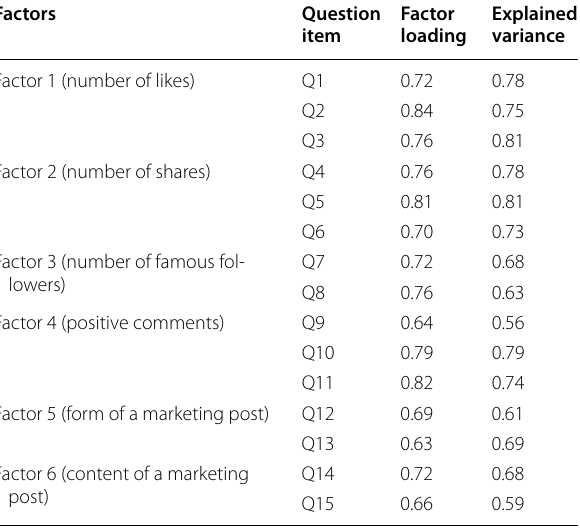
Table 7 Extracted factors, factor loadings and explained